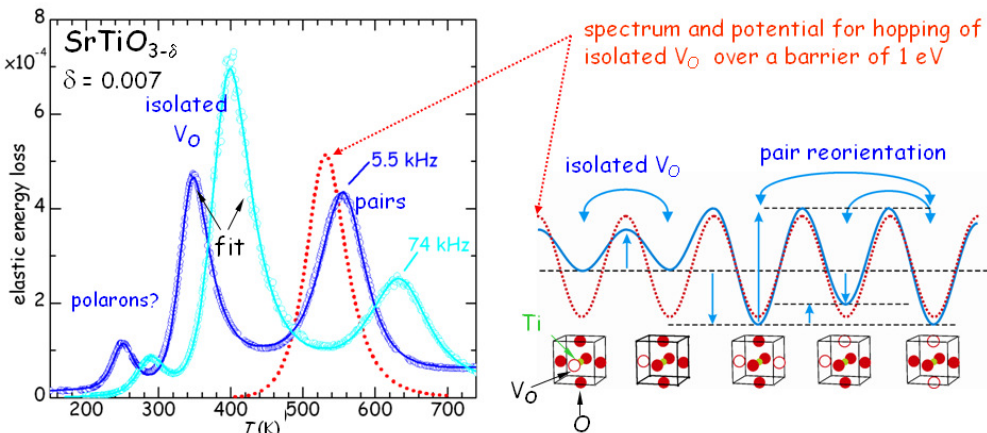
Figure 4. Left: anelastic spectrum of SrTiO 3 − δ with δ = 0.007 measured at 5.5 and 74 kHz and fit assuming contributions from the V O configurations represented in the right side with the blue potential. The dashed red peak on the left would be the anelastic spectrum from isolated V O hopping over a barrier of 1 eV (dashed red potential). Adapted with permission from Ref. [26], copyrighted by the American Physical